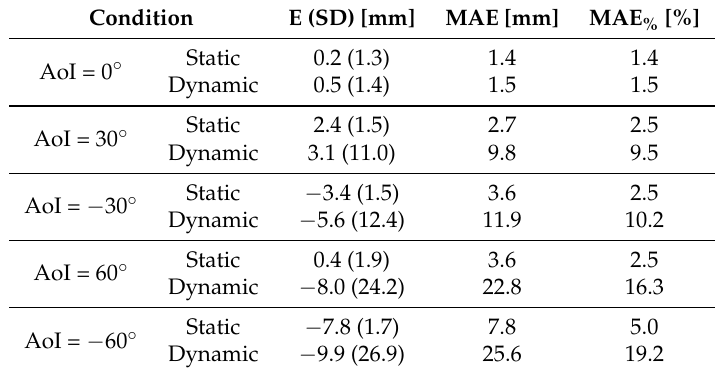
Table 3. Overall mean error with standard deviation (E (SD)), mean absolute error (MAE) and mean absolute percentage error (MAE % ) of the distance for the five conditions using a white